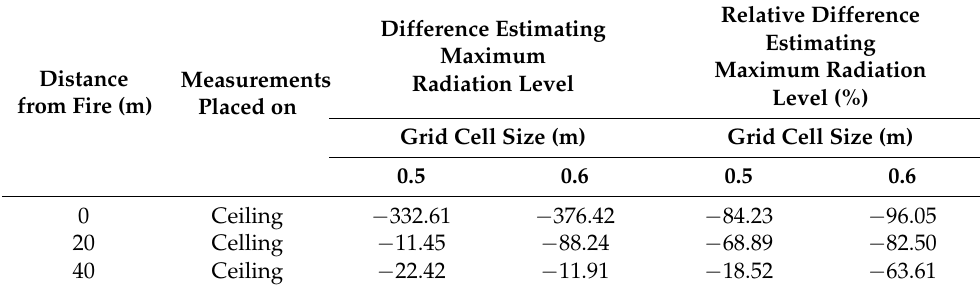
Table 3. Comparison between maximum simulated and experimental values of radiation